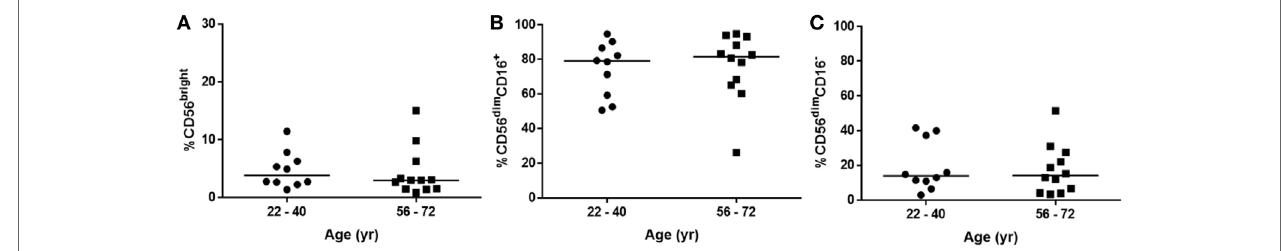
FigUre 2 | Natural killer cell subpopulation proportions are not affected by age. (a) CD56 bright , (B) CD56 dim CD16 + , and (c) CD56 dim CD16 − proportions in peripheral blood of healthy donors aged 22–40 ( N = 10) and 56–72 ( N = 12). Statistical analysis by Mann–Whitney U test, lines describe